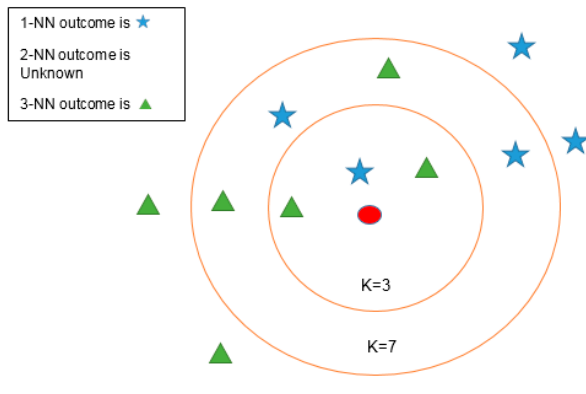
Figure 7. A K-nearest neighbor model.